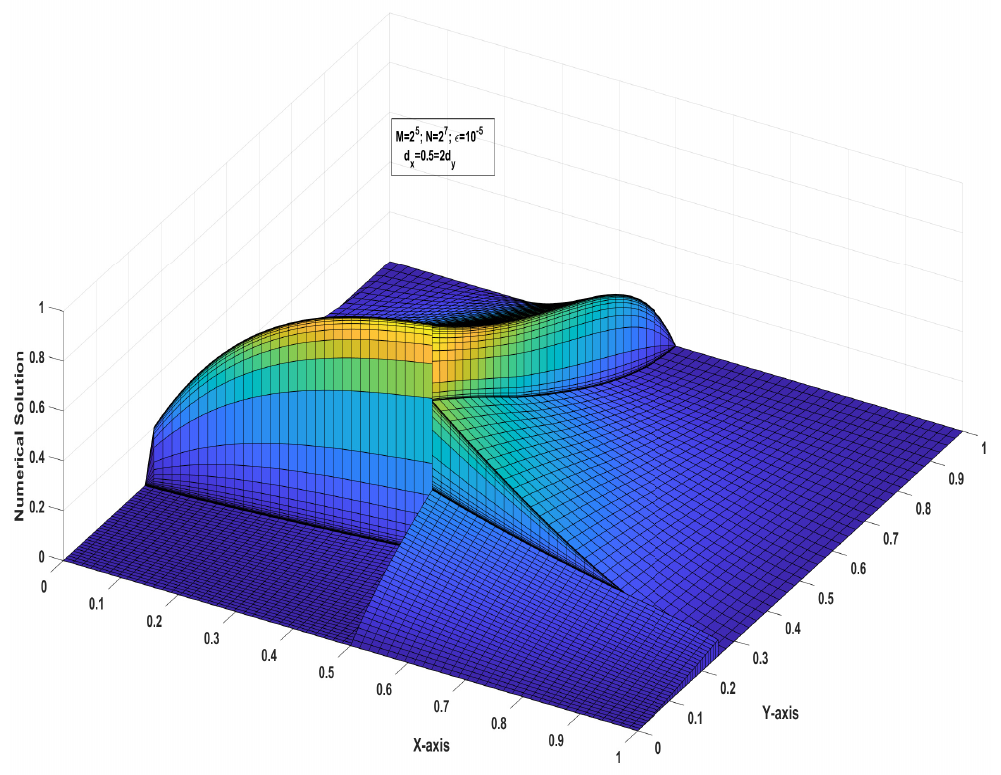
Figure 4. Numerical solution of Example 2 for fixed M = 2 5 , N = 2 7 , ε = 10 − 5